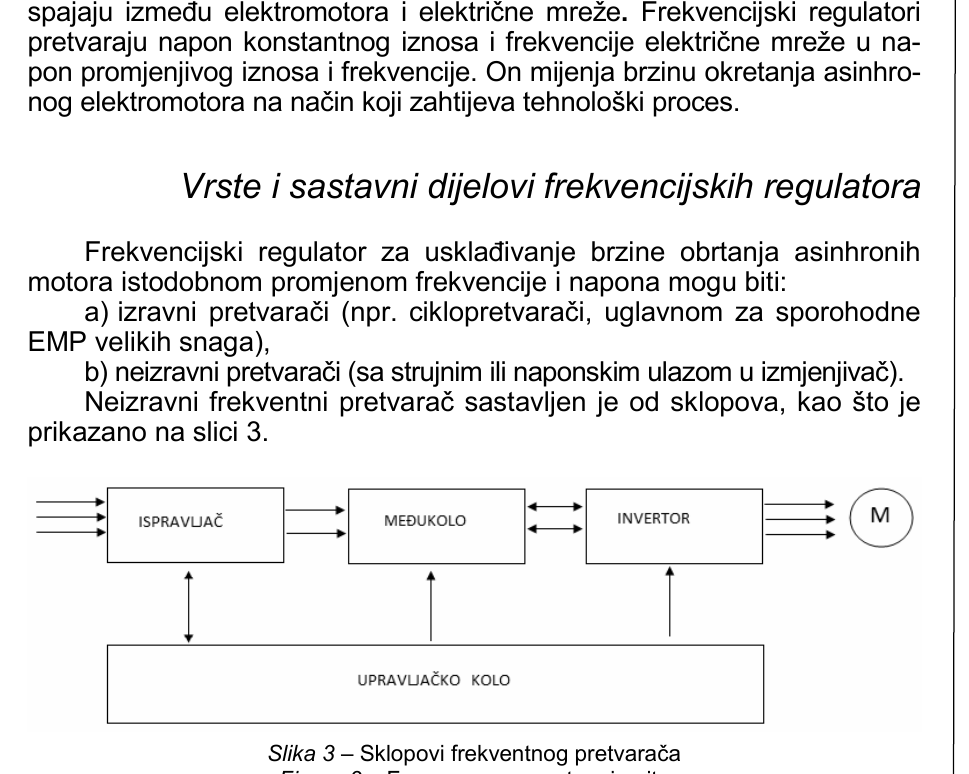
Figure 3 – Frequency converter